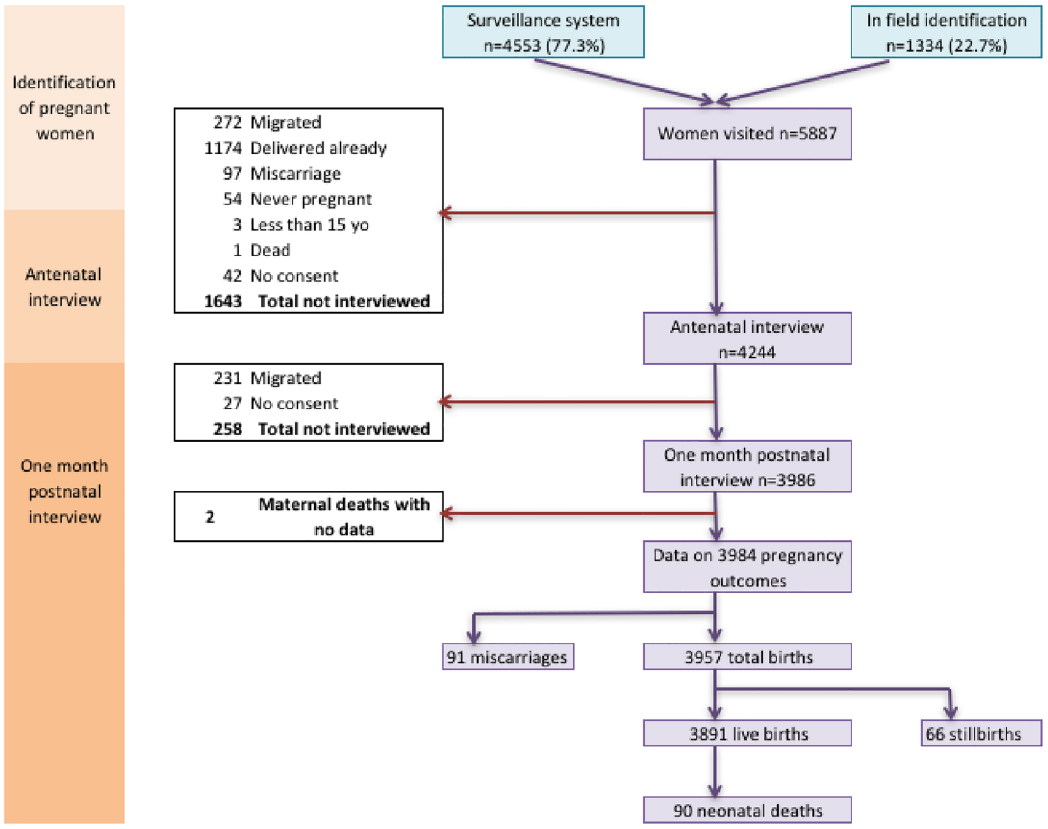
Fig 1. Case flow and outcomes for women recruited and followed